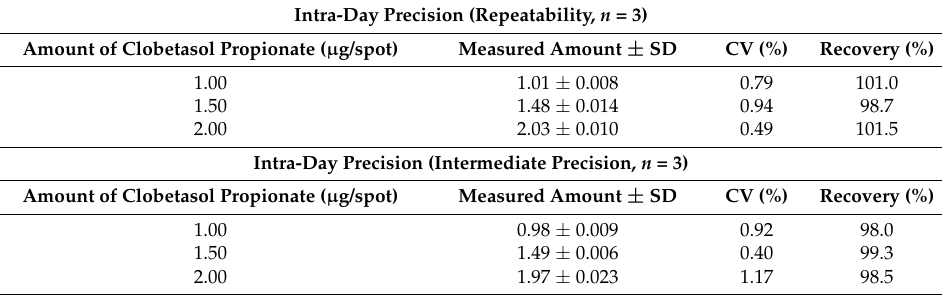
Table 4. Results of method